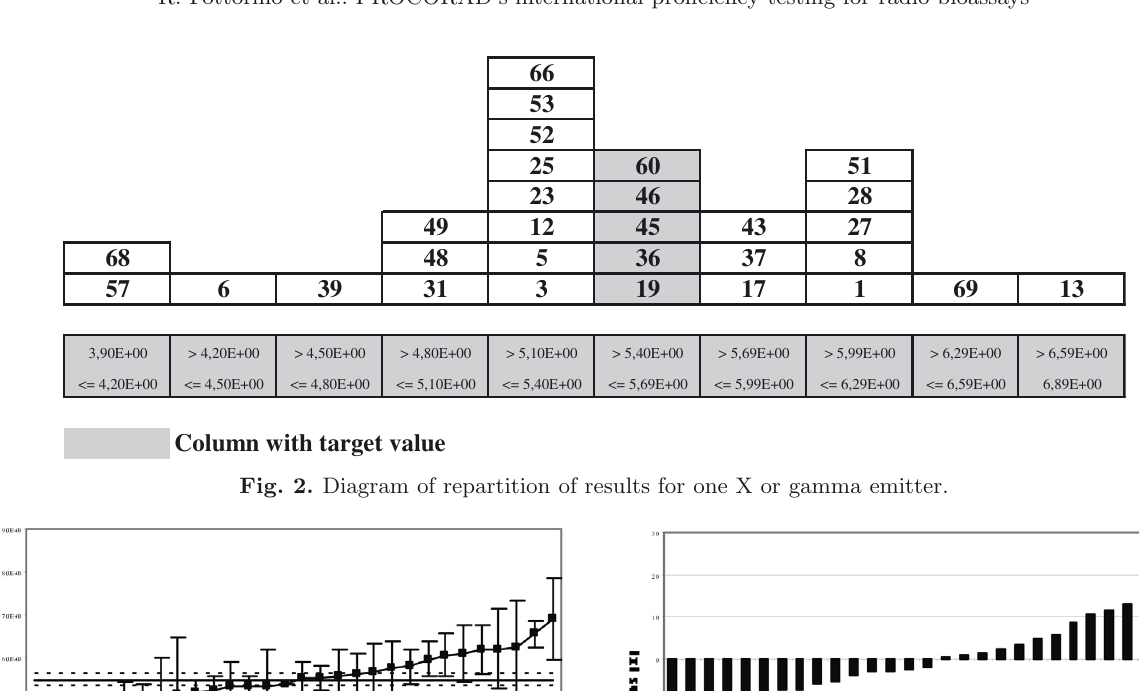
Figure 7 makes the synthesis for each